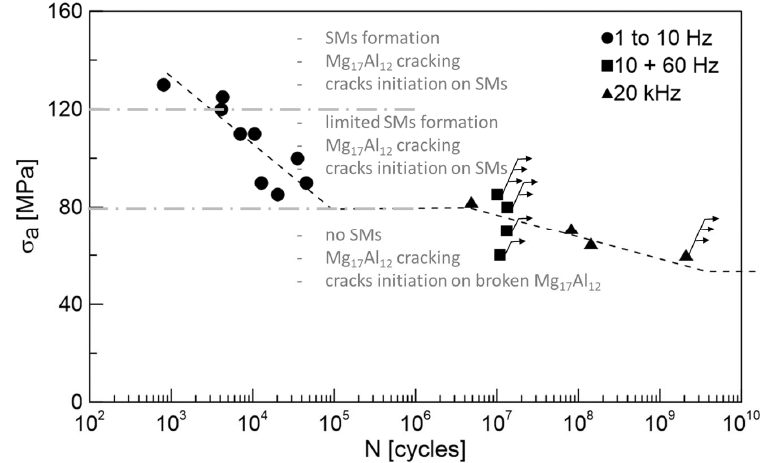
Figure 6. Change in the fatigue crack initiation mechanism for cast AZ91 magnesium alloy. Arrows indicate the run ‐ out specimens, exceeding 1 × 10 7 or 2 × 10 9 cycles depending on the test conditions.